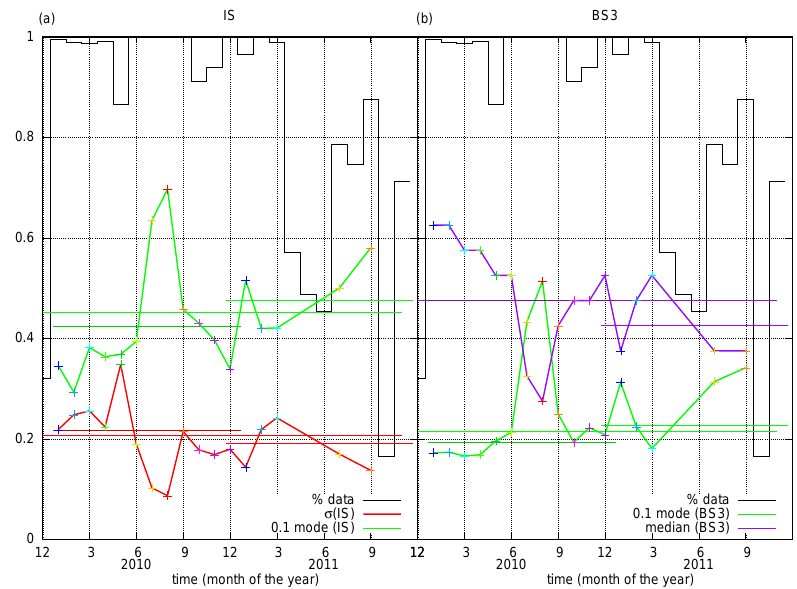
Fig. 7. The seasonal variations in the background sea level can be seen by plotting the standard deviation (red) and the mode (green) of the monthly EFDs of | IS | (a) , and of the mode (green) and median (violet) of the monthly EFDs of BS3 (b) . The standard deviation, mode and median of EFD for the whole database and of the yearly EFD are indicated with horizontal lines (in the same colours as the monthly parameters). The percentage of available data of each monthly EFD is plotted in black. Only months with at least 75% of data are used to plot the variations over time (line and